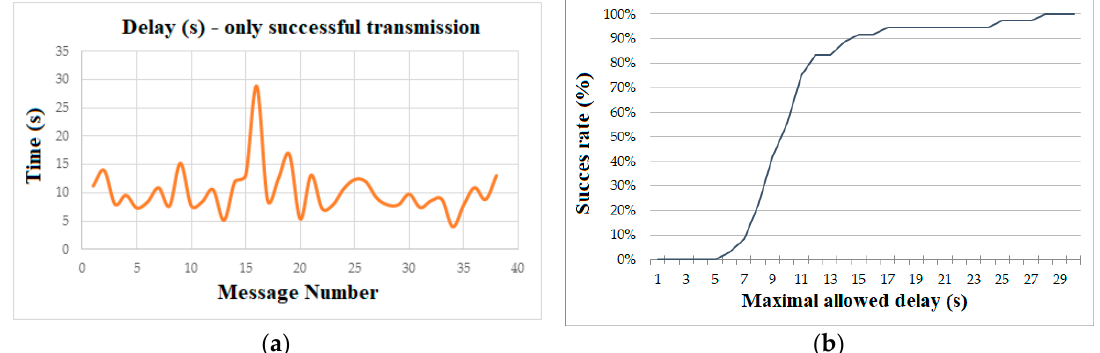
Figure 5. SBD message transmission through the Iridium network: ( a ) raw delay data; ( b ) success rate as a function of maximal application delay.